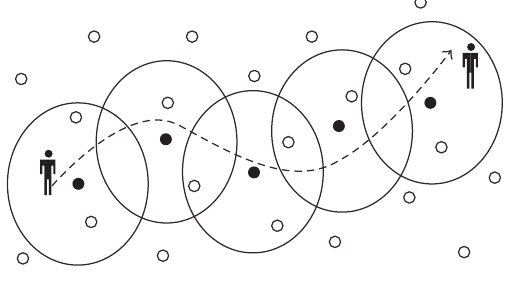
Figure 1: Diagram clustering of